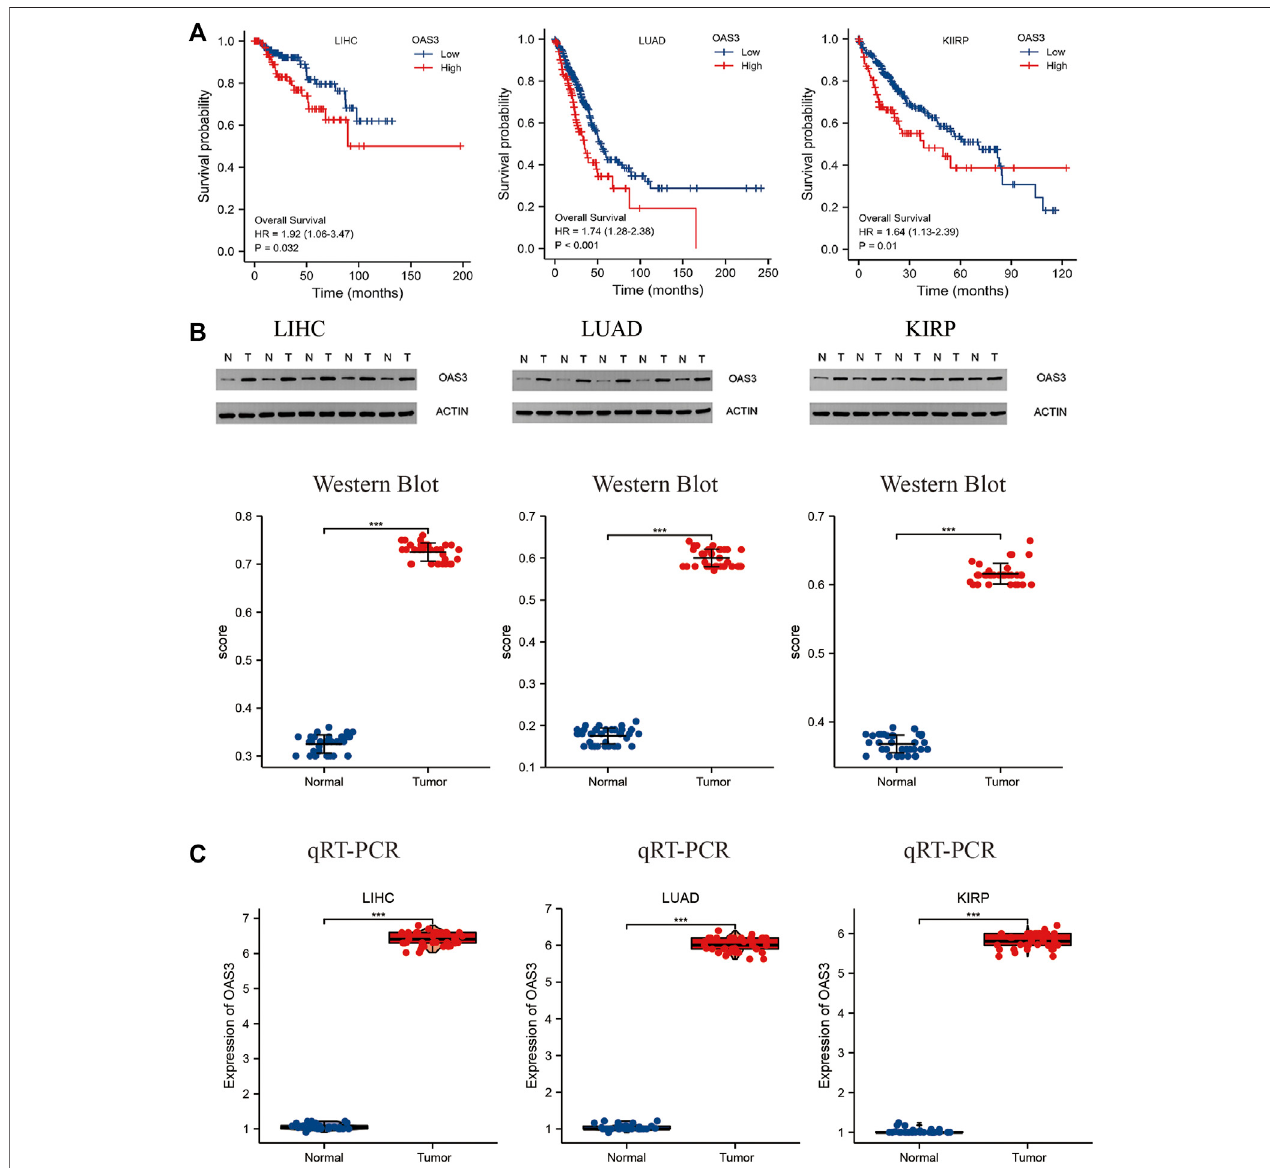
FIGURE 4 | (A) Relationship between OAS3 and OS of LIHC, LUAD, KIRP in validation cohort. The results showed that patients with high OAS3 expression had a poorprognosisinthethreetumorsmentionedabove. (B,C) :ResultsofWesternBlot (B) andqRT-PCR (C) showedaclearoverexpressioninproteinexpressionlevelsof OAS3 in validation